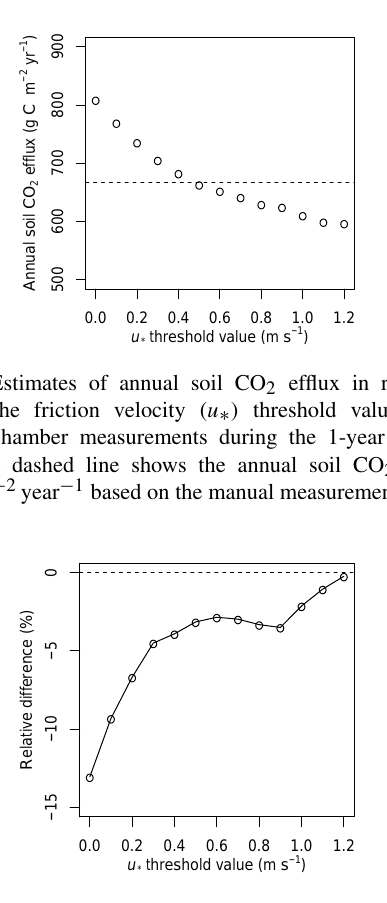
Figure 8. Relative difference between the estimates of annual soil CO 2 efflux based on daytime (09:00–15:00CET) data at different friction velocity ( u ∗ ) threshold values, compared to the estimates of annual soil CO 2 efflux based on data for the entire day at different friction velocity ( u ∗ ) threshold values.